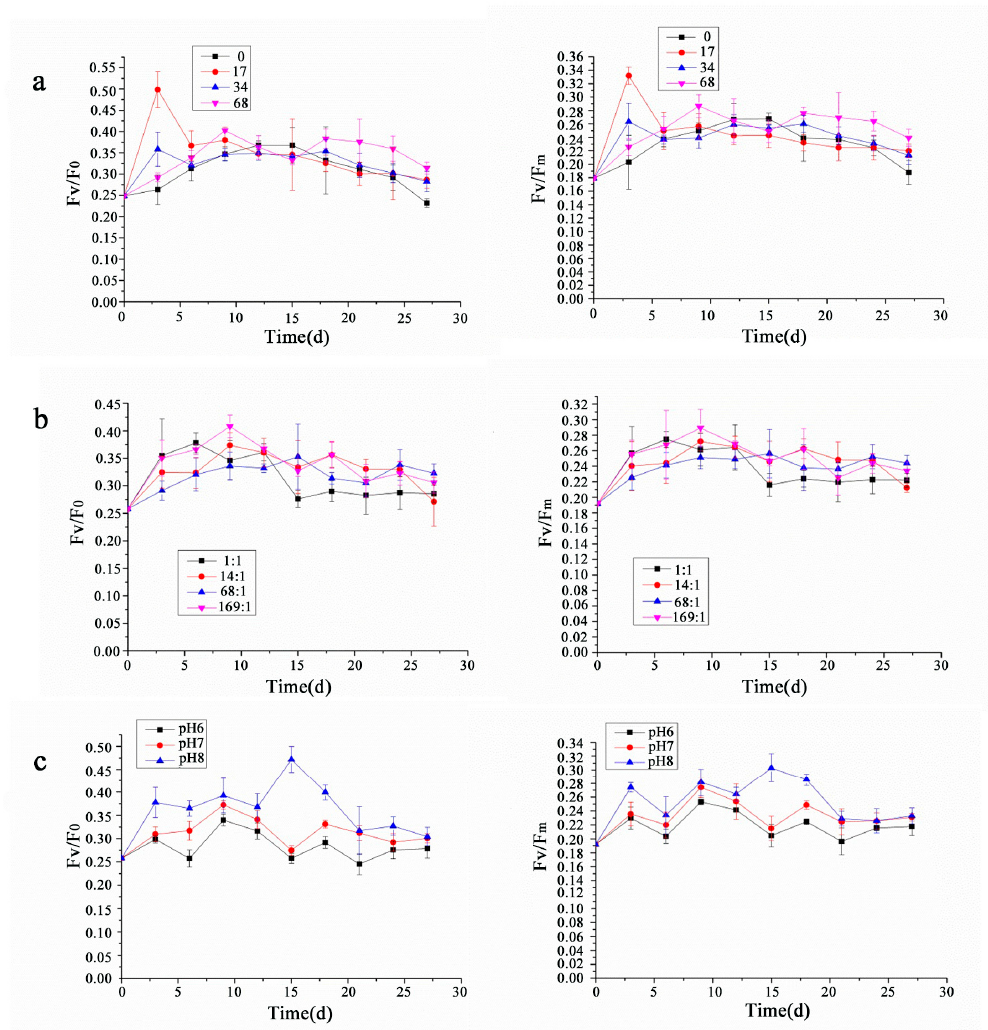
Figure 3. The chlorophyll fluorescence of P. purpureum under different environmental factors. Data were expressed as mean ± standard error. ( a ). The chlorophyll fluorescence of P. purpureum at different salinities. ( b ). The chlorophyll fluorescence of P. purpureum at different nitrogen-to-phosphorus ratios. ( c ). The chlorophyll fluorescence of P. purpureum at di ff erent pH